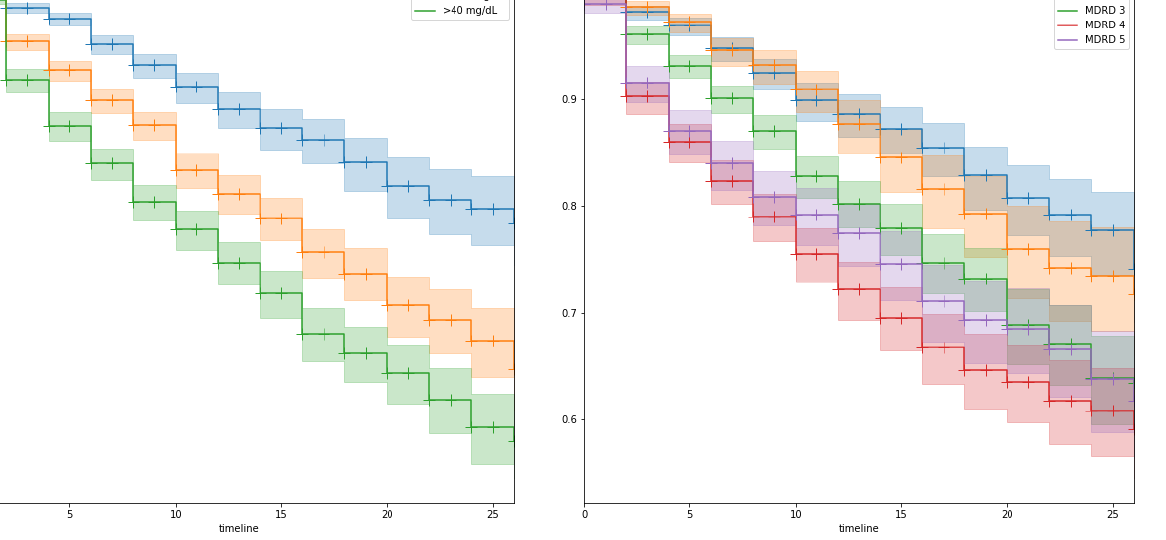
Fig. 1. Kaplan-Meier curves for 28 days all cause mortality of eICU patients according admission BUN level. group comparison by log-rank test, P <0.001